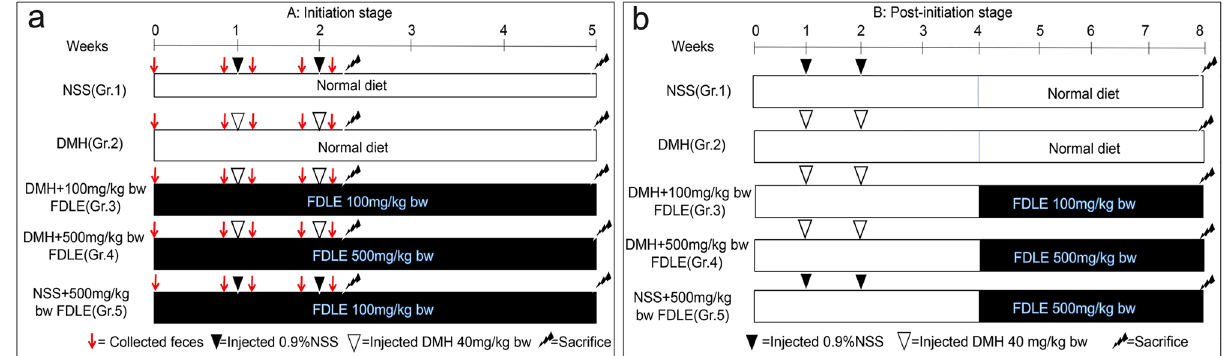
Number of ACF/rat a Treatment Aberrant crypt/focusProximal Distal Rectal Total colon (% inhibition) NSS (Gr.1) 0 ± 0 0 ± 0 0 ± 0 DMH (Gr.2) 115 ± 30 100 ± 32 26 ± 10 241 ± 69 1.6 ± 0.1 DMH + 100 mg/kg bw FDLE (Gr.3) 117 ± 29 93 ± 26 227 ± 58 (5.8%) 1.5 ± 0.1 DMH + 500 mg/kg bw FDLE (Gr.4) 57 ± 15* 23 ± 10 151 ± 41* (37.3%) NSS + 500 mg/kg bw FDLE (Gr.5) 0 ± Table 2. The number of ACF in DMH-treated rats with and without FDLE administration in initiation stage. a Mean ± SD of 6 rats per group, * p < 0.05; Significantly different from Gr.2.